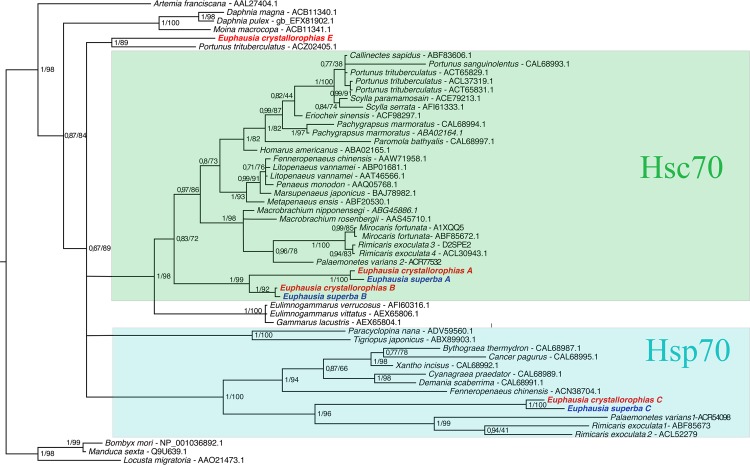
Phylogeny of the HSP70 family in Eucrustacea based on Maximum Likelihood and Bayesian analyses of amino acid data set.Numbers above branches are posterior probabilities and bootstrap values (based on 100 replicated).